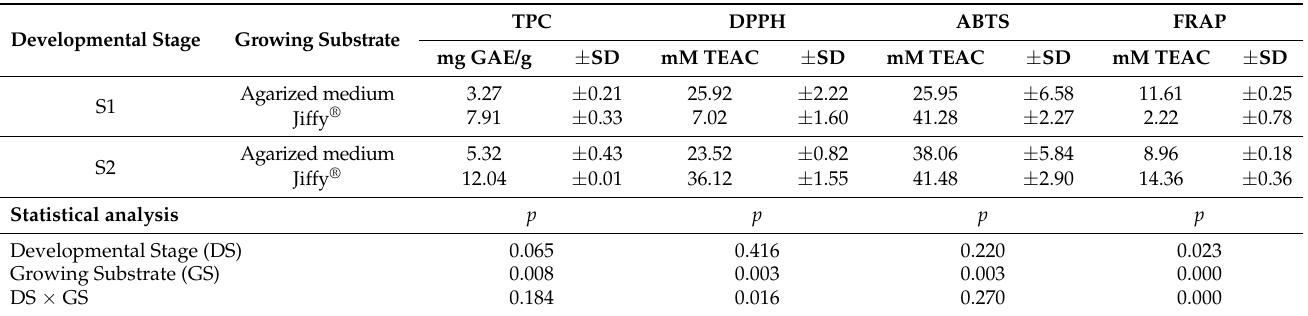
Table 2. Influence of sprout developmental stage and growing substrate on total phenolic contents (TPC), DPPH, ABTS and FRAP scavenging capacity of Moringa cotyledons.